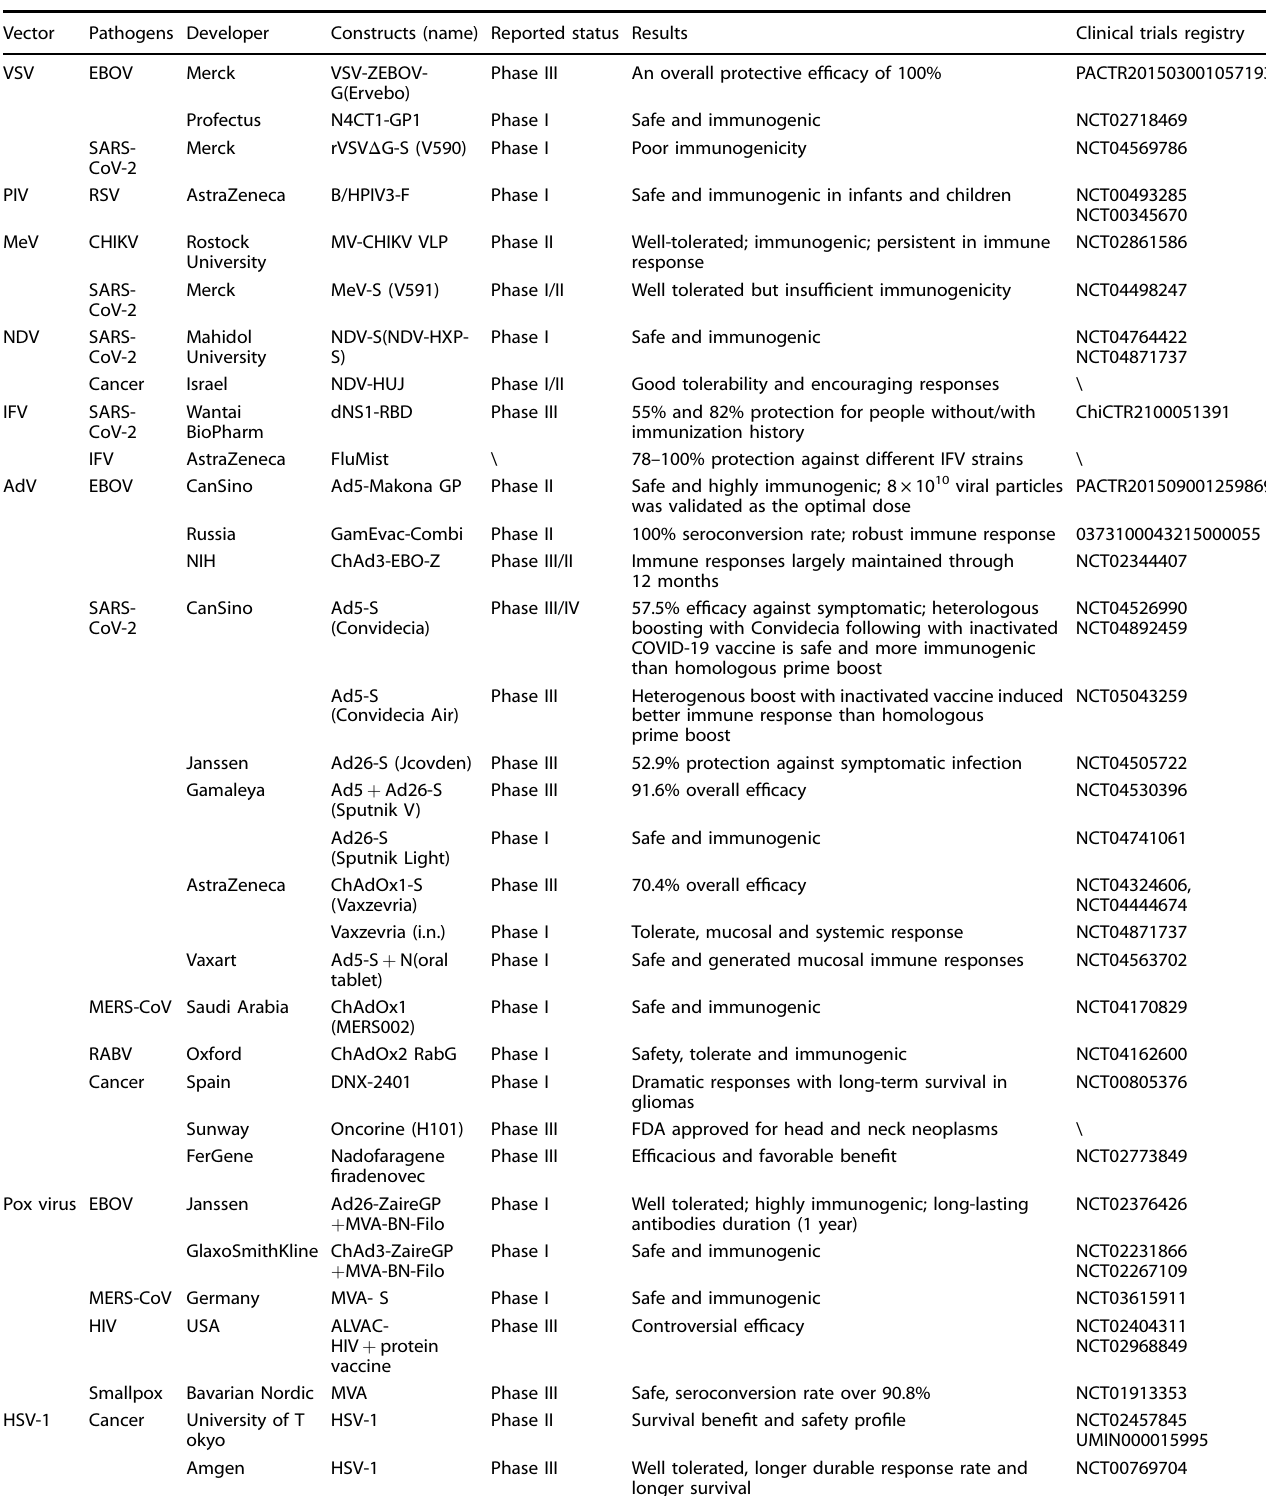
Table 10. Viral vectored vaccines in clinical trials Vector Pathogens